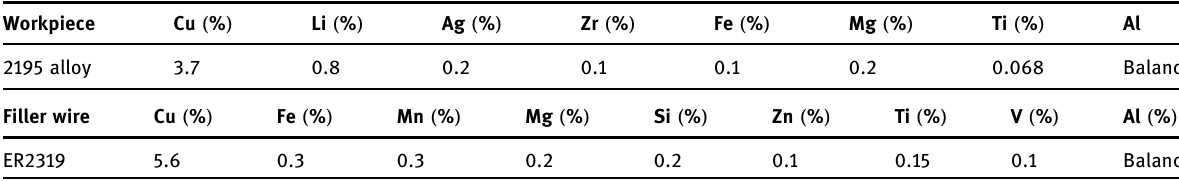
Table 1: Chemical compositions of the workpiece and fi ller wire Workpiece